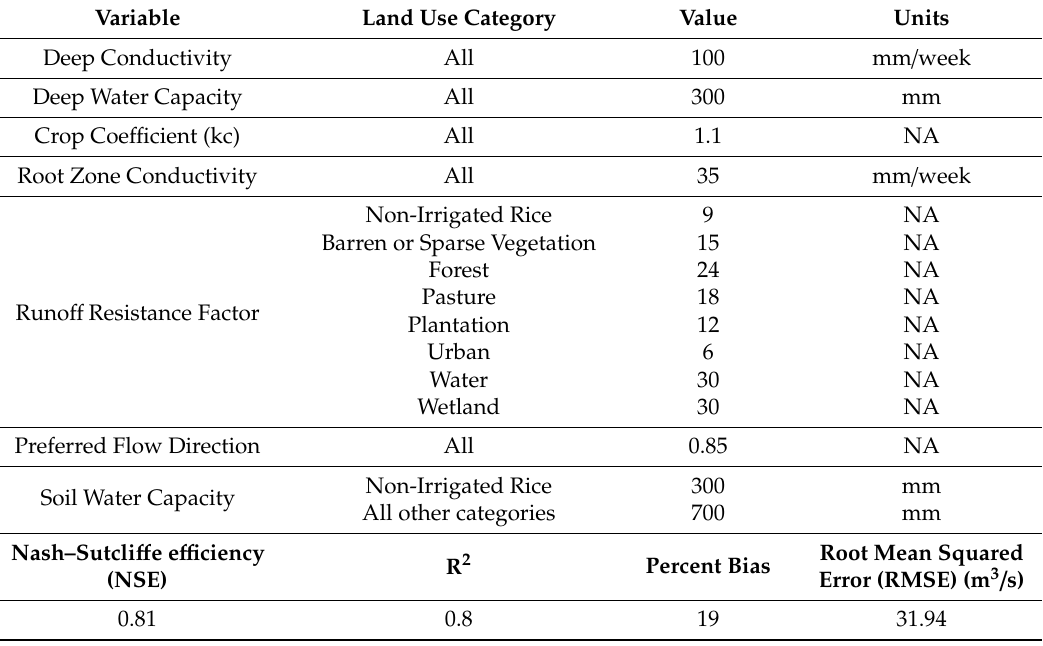
Table 5. Final parameter values and goodness of fit statistics for streamflow